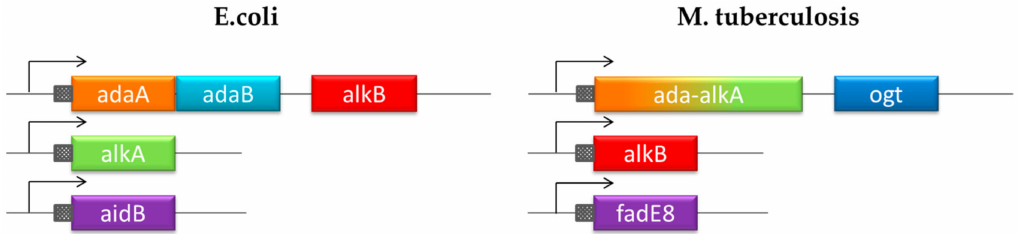
Figure 1. Chromosomal organization of the adaptive response to alkylation stress in E. coli and Mycobacterium tuberculosis